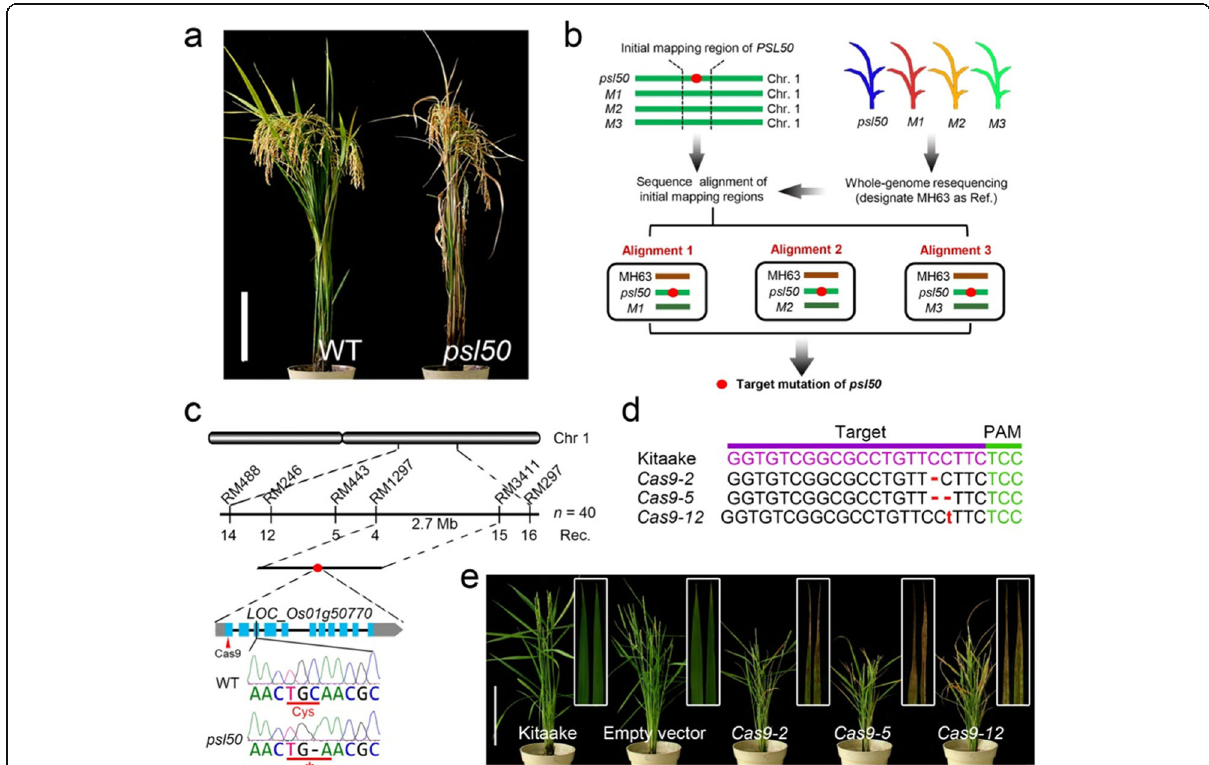
Fig. 1 Identification of PSL50 by IMBR strategy. a Phenotype of WT and psl50 at the mature stage. Scale bar = 20 cm. b Identification of target mutation of psl50 by IMBR strategy. Red dot indicates the causative mutation responsible for the psl50 phenotype. c Initial mapping of PSL50 and verification of target mutation in PSL50 . d Deletion and insertion mutation at the target site of 1st exon in three representative knockout lines generated by CRISPR/Cas9 in ‘ Kitaake ’ background. The Cas9 – 2 , Cas9 – 5 and Cas9 – 12 lines are homozygous mutants carrying a 1-bp deletion, a 2- bp deletion and a 1-bp insertion on both homochromosomes, respectively. e Phenotype of three representative T 0 knockout lines at the heading stage. Insets display magnified views of flag leaves. Empty vector represents transgenic Kitaake plant transformed with CRISPR/Cas9 empty vector. Scale bar = 20